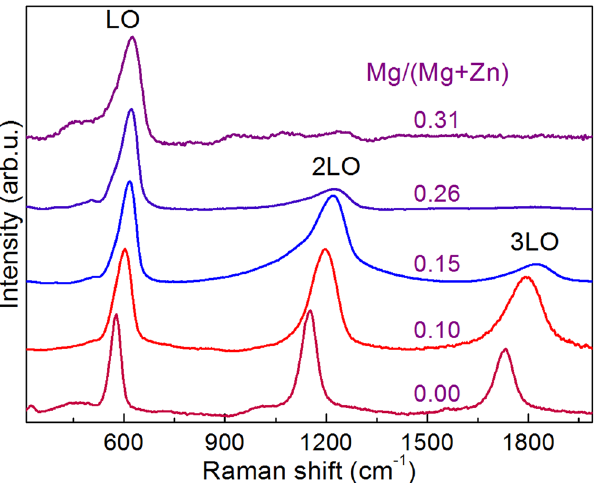
Figure 3. Raman scattering spectra (normalized to the intensity of the main LO peak) measured from layers series (i) that were grown with different Mg